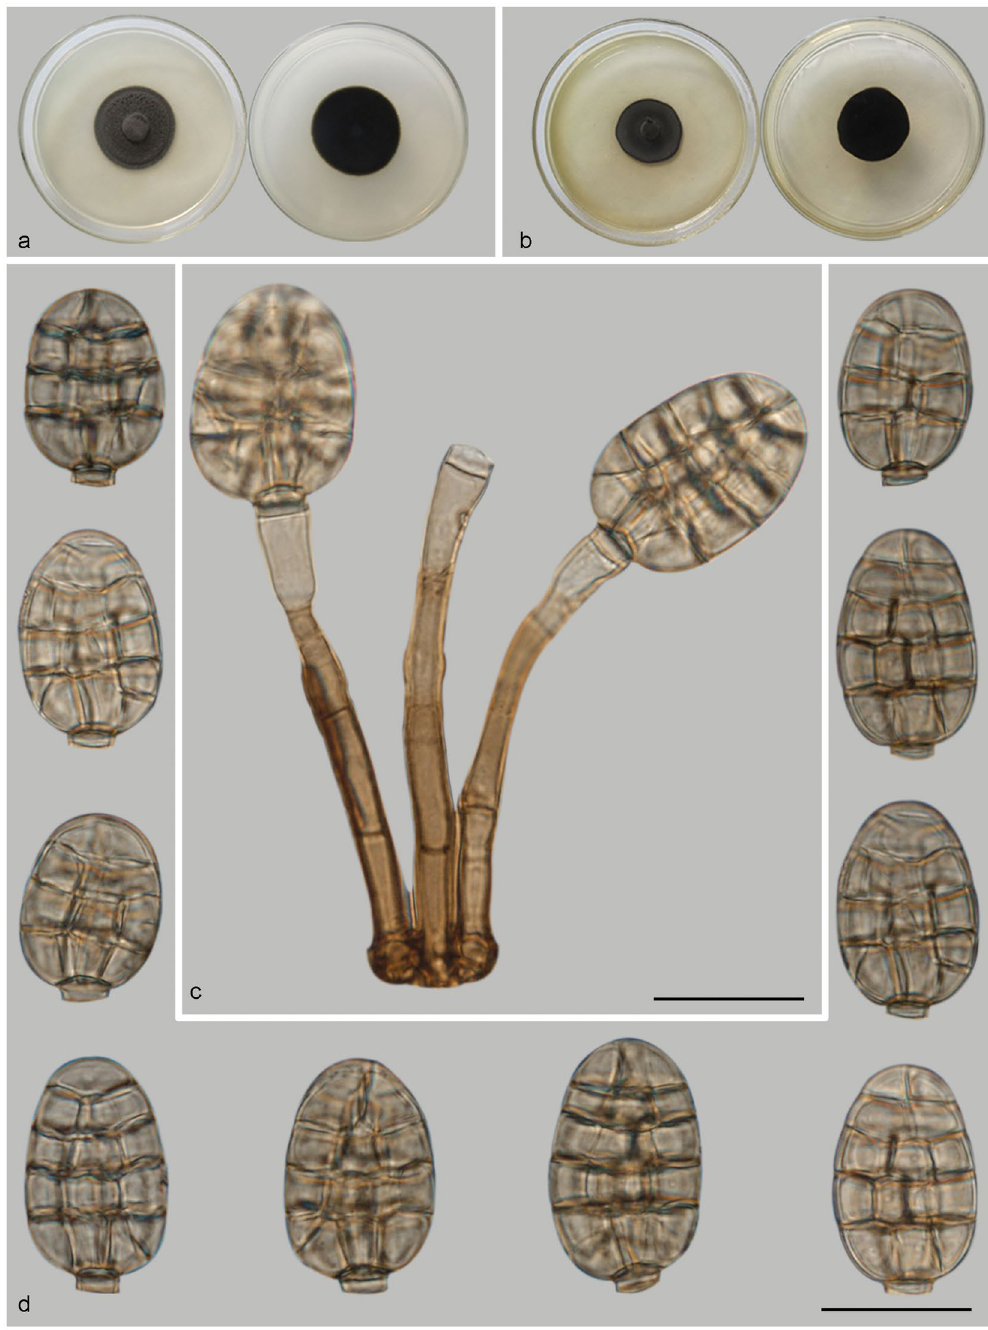
Figure 8. Acrodictys peruamazonensis. ( a ) Colony on PDA (surface and reverse). ( b ) Colony on MEA (surface and reverse). ( c , d ) From natural substrate (HSAUP H4694): ( c ) Conidiophores with conidia, ( d ) Conidia. — Scale bars = 20 μ